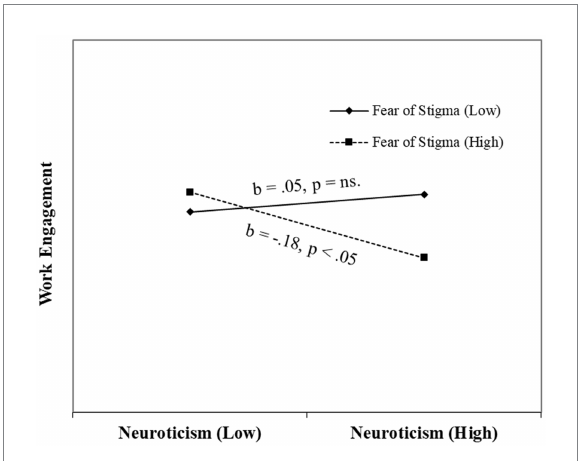
FIGURE 3 Interaction effect of perceived stigma on Neuroticism–Work Engagement